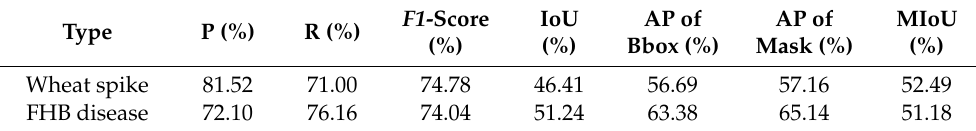
Figure 5. Selected examples of instance segmentation on correct detections of wheat spikes under three complex conditions in the test dataset, ( a ) high-density wheat spikes, ( b ) wheat spikes with overlapping boundaries, and ( c ) wheat spikes cut at the image borders. For each example, the original image (left) and the corresponding recognition result (right) are displayed. Table 3. Results of Mask-RCNN for wheat spike and Fusarium head blight (FHB) disease